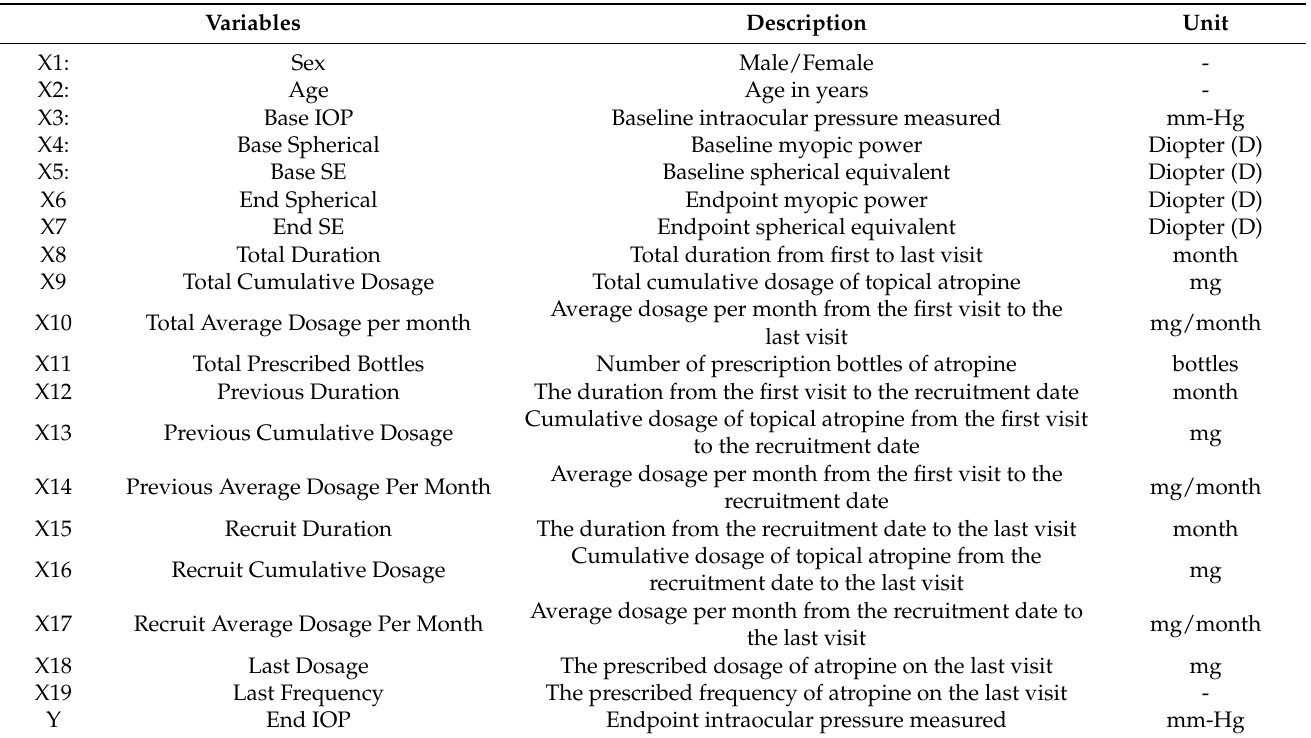
Table 2. Variable